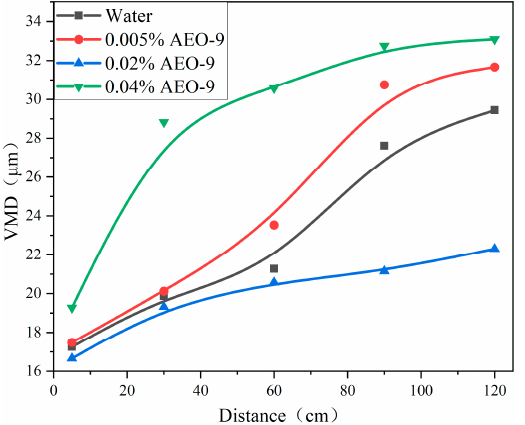
Figure 8. The spray droplet size of the AEO-9 solution at di ff erent